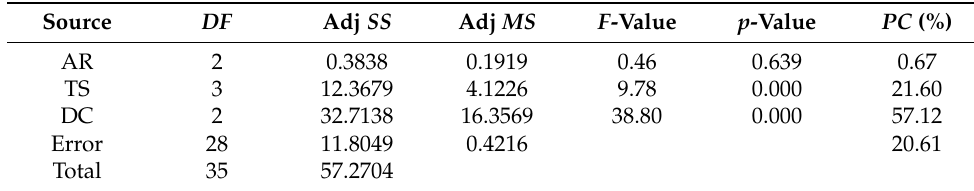
Table 9. ANOVA results for the 15 mm material